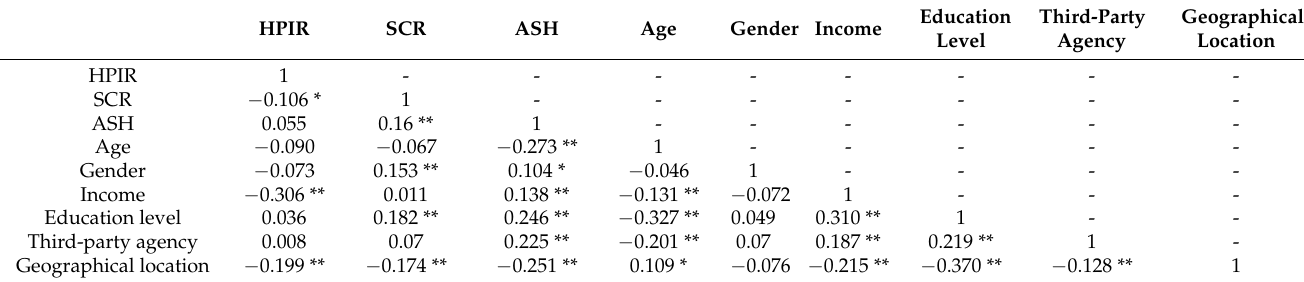
Table 4. Correlation coefficient matrix of the independent variables and control variables.